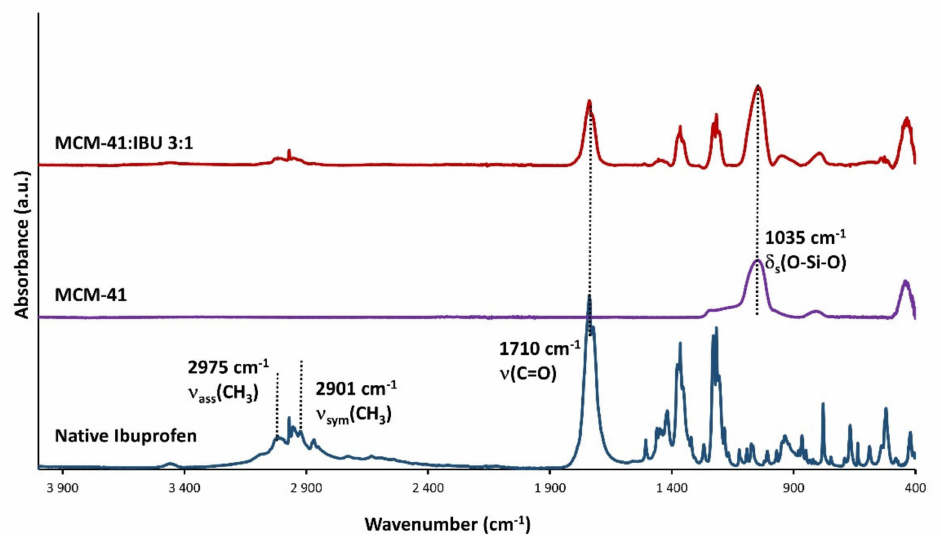
Figure 13. FTIR spectra for unloaded MCM-41, composite MCM-41:IBU 3:1, and native ibuprofen. Data provided courtesy of Katarzyna